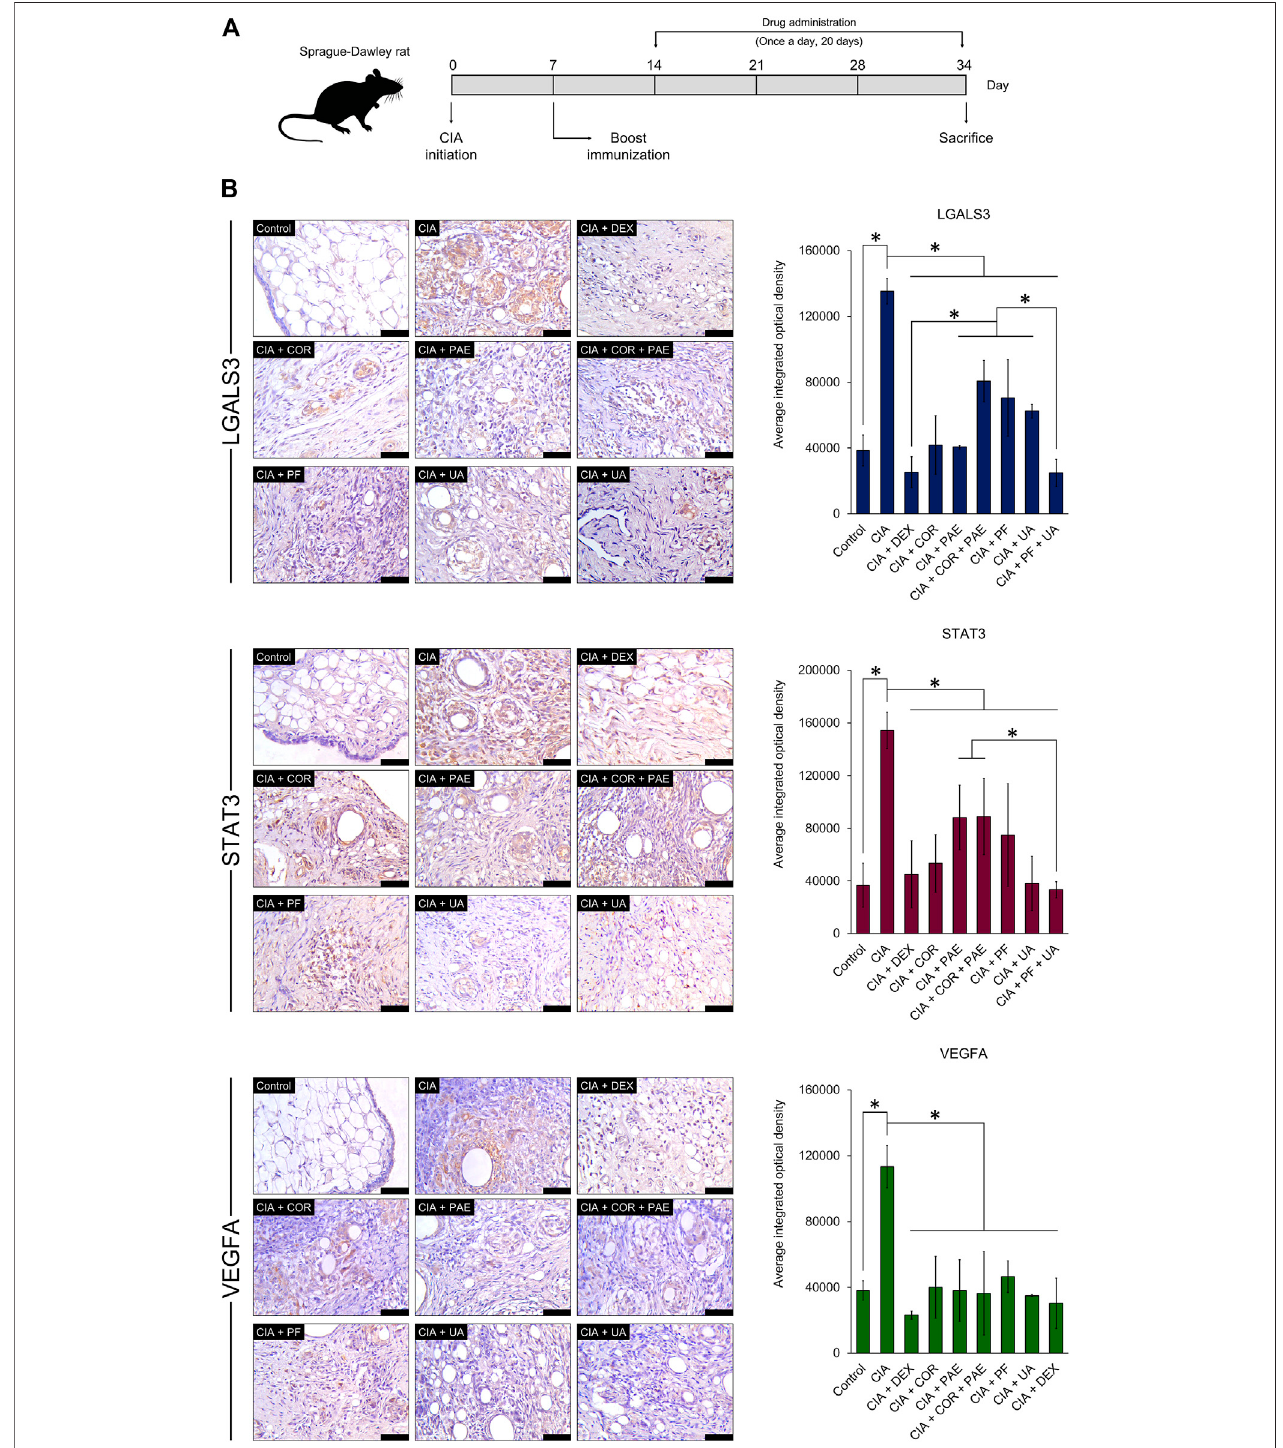
FIGURE8 | Experimental validationoftarget protein expression in CIA rat model. (A) Sprague-Dawley rats were induced byCIA and treated with Cornus of fi cinalis (COR, 3.36 g/kg/d) or/and Paeonia lacti fl ora (PAE, 6.27 g/kg/d), paeoni fl orin (PF, 7.5 mg/kg/d) or/and ursolic acid (UA, 25 mg/kg/d), or dexamethasone (DEX, 0.5 mg/kg/d) daily for 20 days. (B) After sacri fi ce, synovial tissues were isolated from the rats and immunohistochemical staining was performed to assess the positive expression (brown areas in images) of LGALS3, STAT3, and VEGFA. Scale bar (cid:2) 50 μ m. Areas of positive staining were quanti fi ed using ImagePro Plus. The data are expressed as the average integrated optical density ± standard deviation ( n (cid:2) 3). * indicates p < 0.05.